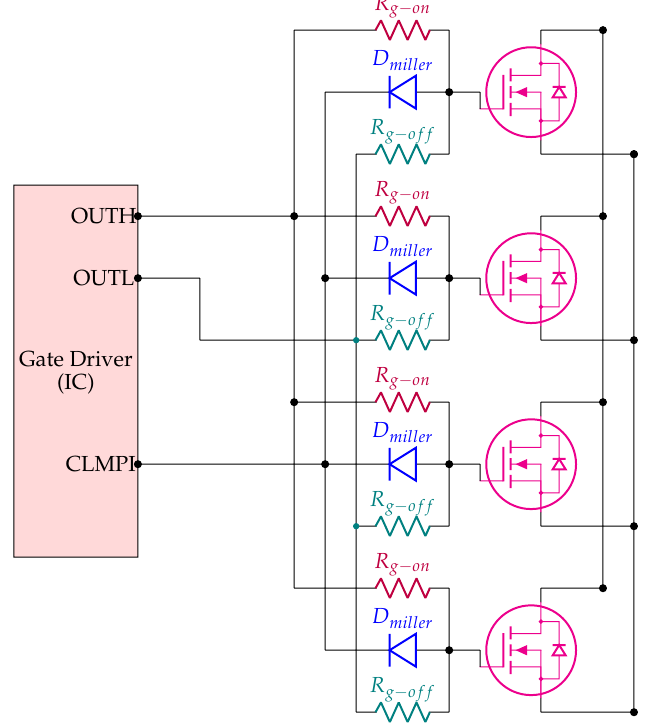
Figure 5. Schematic of Active Miller Clamp protection.